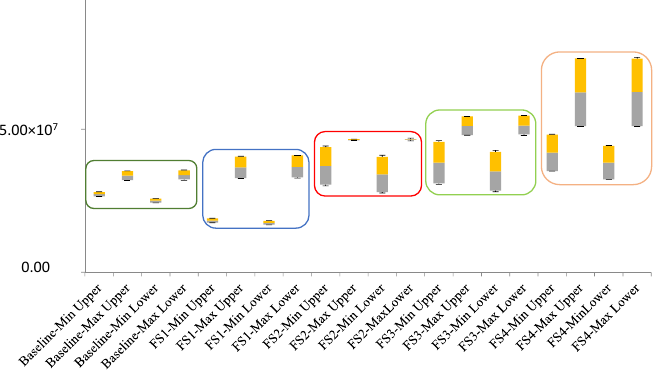
Figure 5. Box plots for the four options of annual net optimized benefits for irrigation in EUR for the baseline and the four future scenarios (FS1: Future Scenario 1; FS2: Future Scenario 2; FS3: Future Scenario 3; FS4: Future Scenario